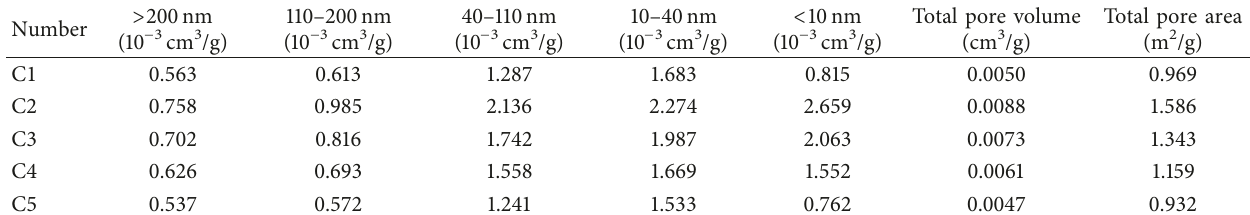
Table 3: Pore size distribution for designed UHPC.